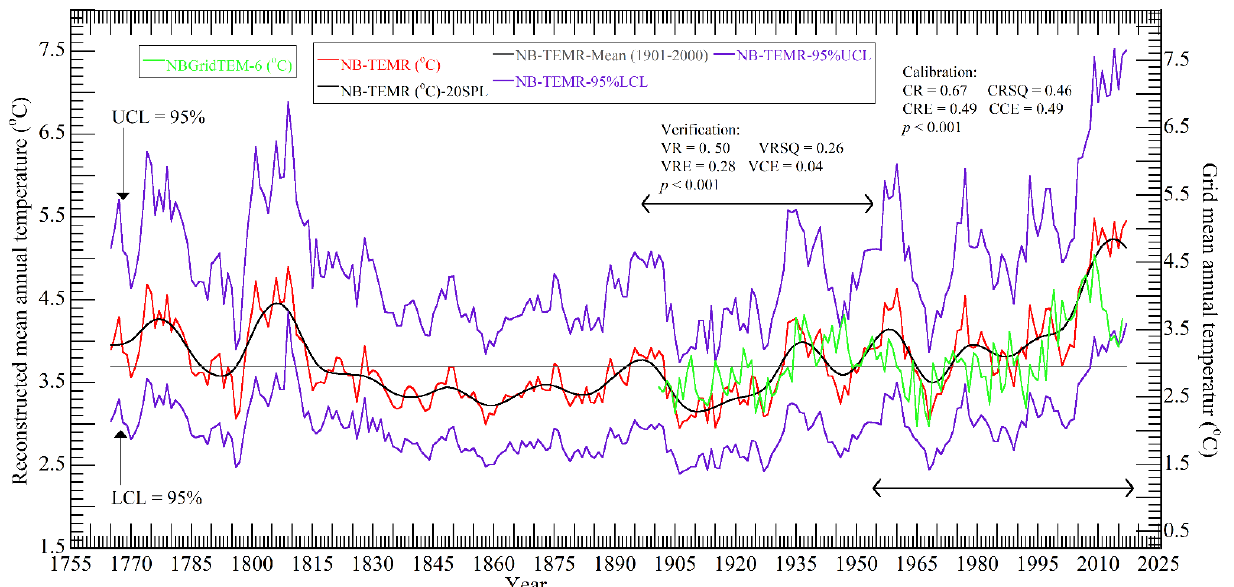
Figure 6. ( a ) Correlation coefficient between NB − CRNS and monthly mean temperatures (NBGridTEM-MM-6) for the period of 1901 – 2016. ( b ) Correlation coefficients between NB − CRNS and monthly mean temperatures (NBGridTEM-MM-6) for the period of 1961 – 2016. The horizontal dashed lines show 5% significant threshold values [70].